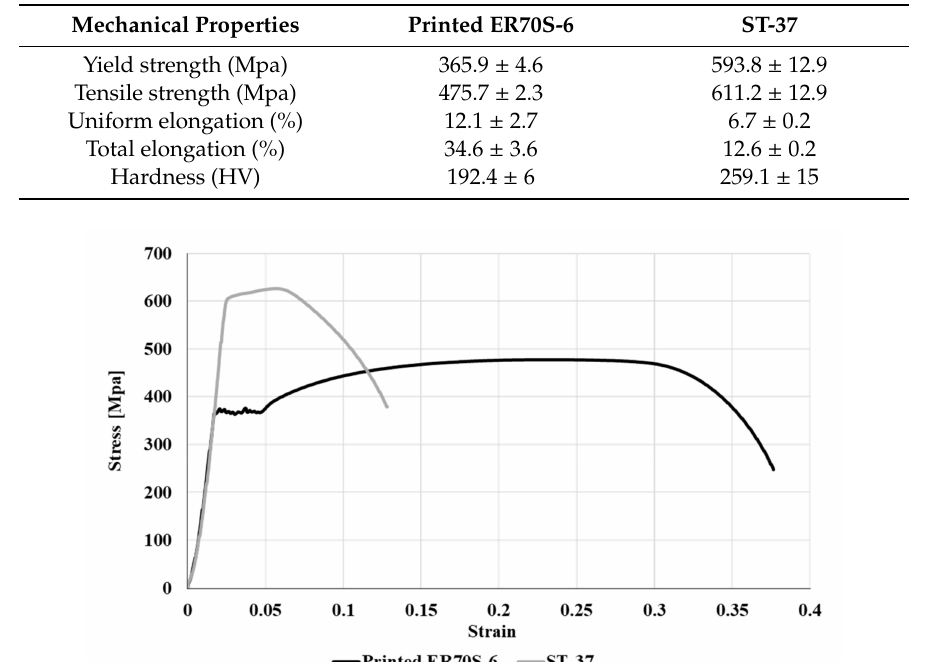
Figure 5. X-ray di ff raction analysis of printed ER70S-6 alloy and the reference ST-37 alloy. Table 2. Typical mechanical properties of printed alloy ER70S-6 and the reference ST-37 alloy.